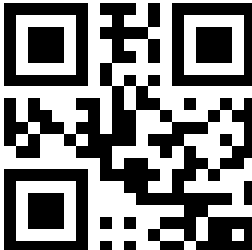
Figure 11. Example of a